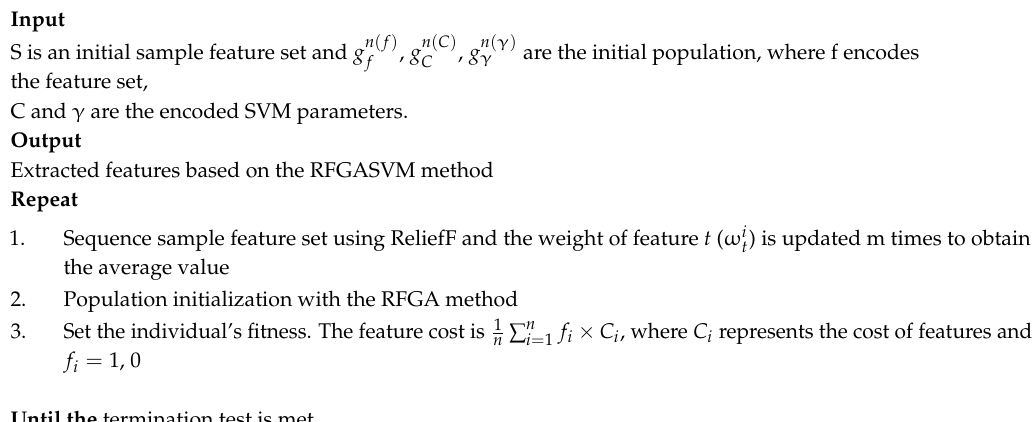
Algorithm 1. Flow of the proposed feature selection method.